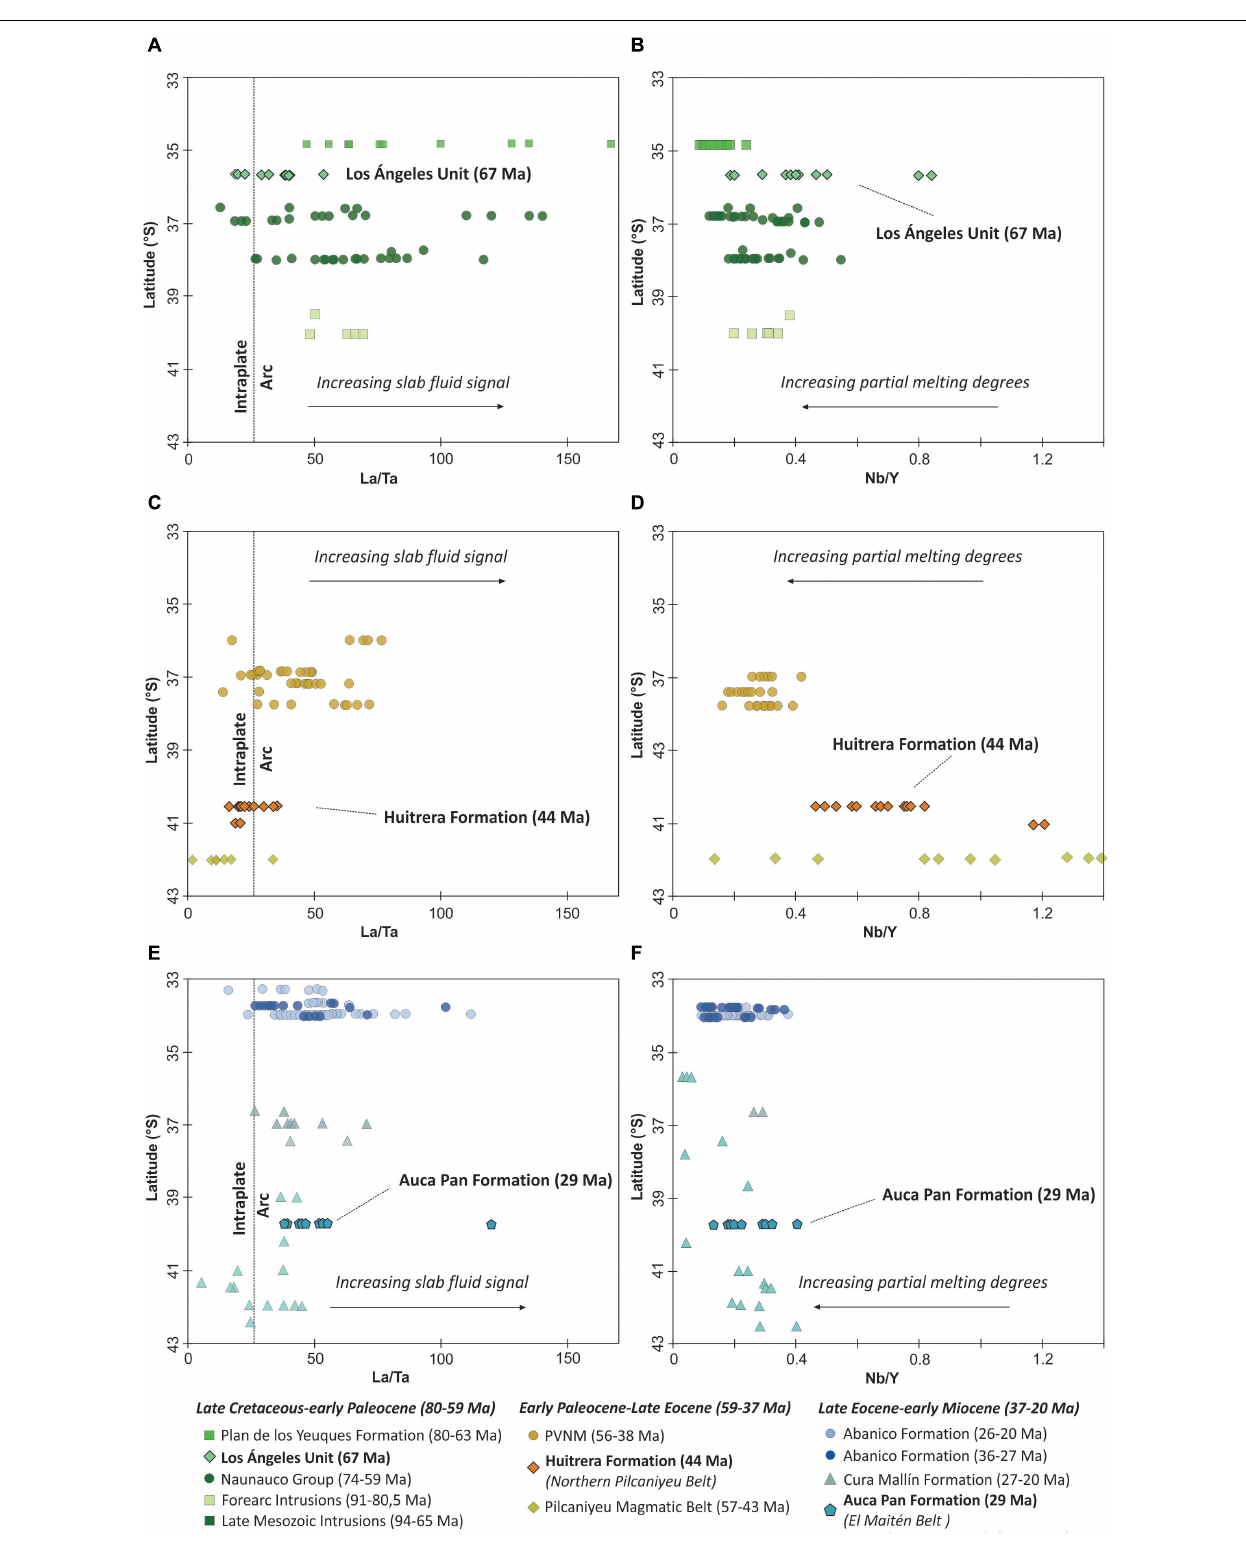
Frontiers in Earth Science |